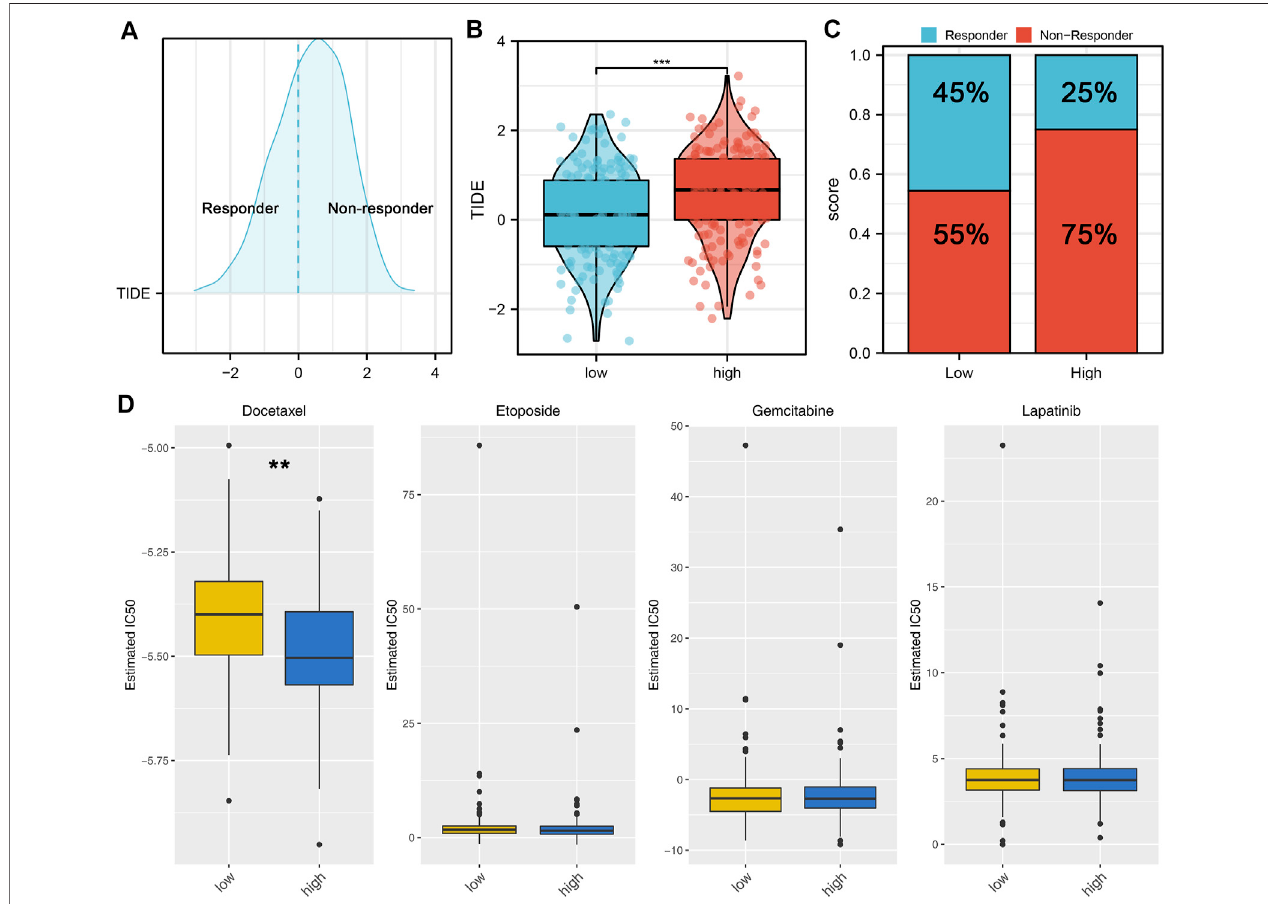
FIGURE 8 | Risk score is associated with the sensibility of immunotherapy and chemotherapy. (A) : According to the TIDE analysis, the patients with the TIDE score < 0werede fi nedasresponders,withtheTIDEscore > 0werede fi nedasnonresponders; (B) :Patientsinalow-riskgroupmighthavealowerTIDEscorethanthose in a high-risk group; (C) : Patients in a low-risk group might have a higher percentage of immunotherapy responders than those in a high-risk group; (D) : GDSC analysis was performed to evaluate the sensibility differences in docetaxel, etoposide, gemcitabine, and lapatinib.